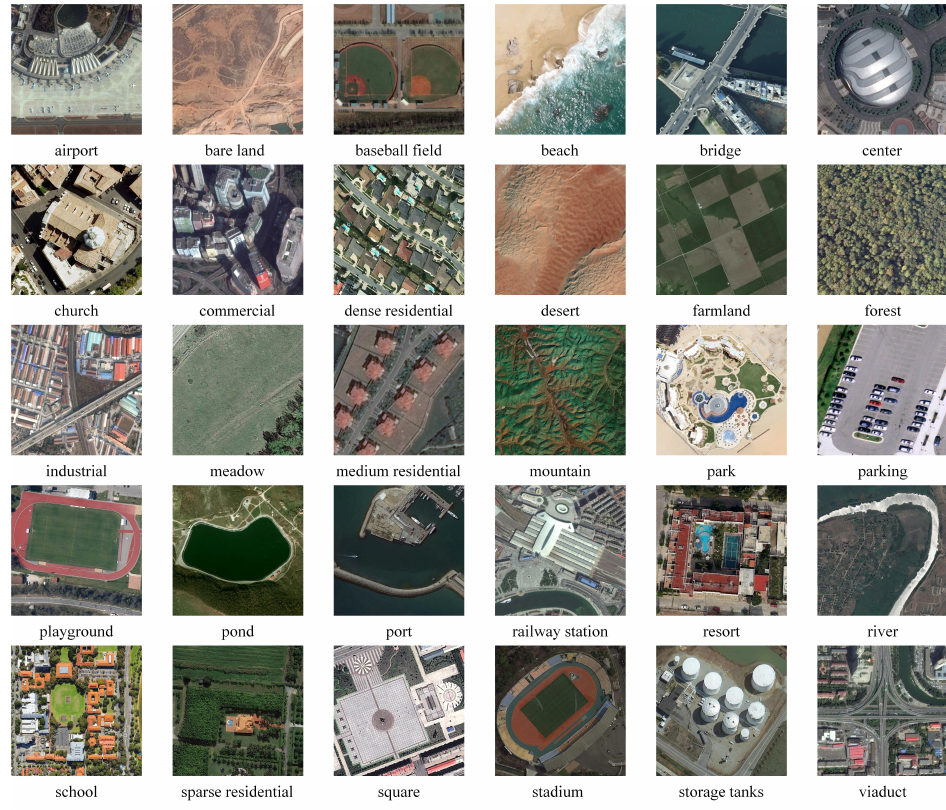
Figure 6. Some samples of